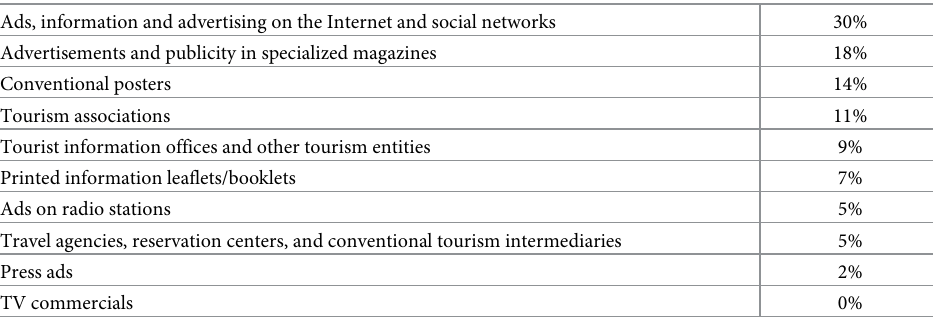
Table 4. Resources and preferences when marketing and promoting active tourism products. Ads, information and advertising on the Internet and social networks 30% Advertisements and publicity in specialized magazines 18% Conventional posters 14% Tourism associations 11% Tourist information offices and other tourism entities 9% Printed information leaflets/booklets 7% Ads on radio stations 5% Travel agencies, reservation centers, and conventional tourism intermediaries 5% Press ads 2% TV commercials 0% Source: Survey of active tourism companies in Cordoba complied by the